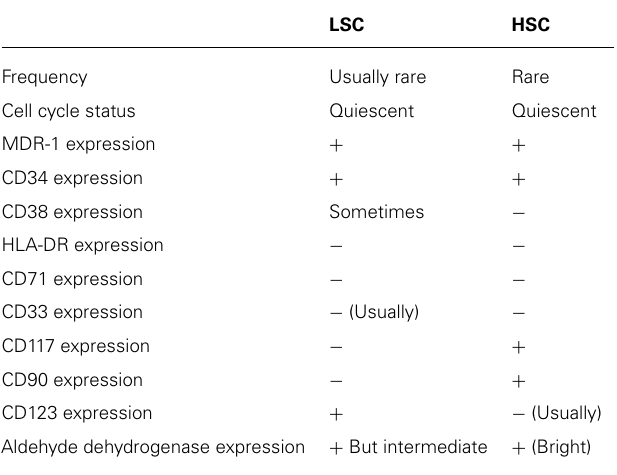
Table 1 | Sample characteristics of leukemia vs. normal stem